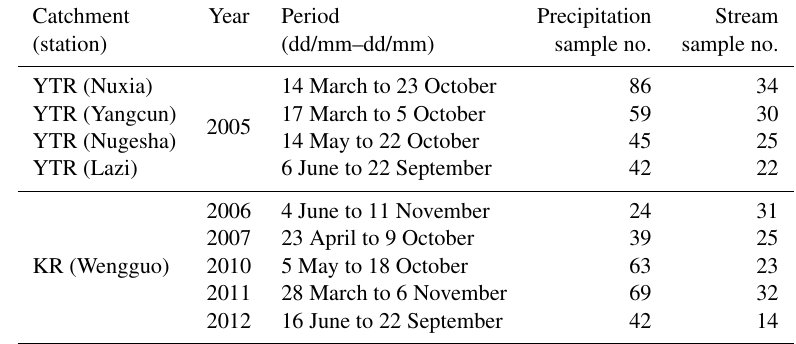
Table 1. Characteristics of precipitation and stream water samples in the YTR and KR catchments. Catchment Year Period Precipitation Stream (station) (dd/mm–dd/mm) sample no. sample